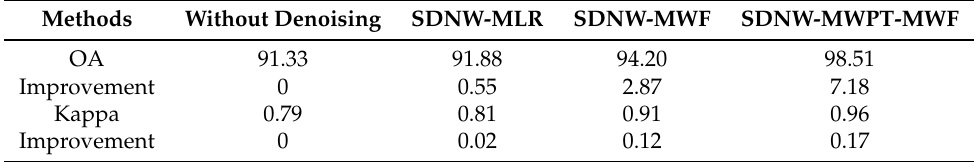
Table 3. OA (%) and Kappa of the classification of the denoised ROSIS HSI, SNR INPUT = 30